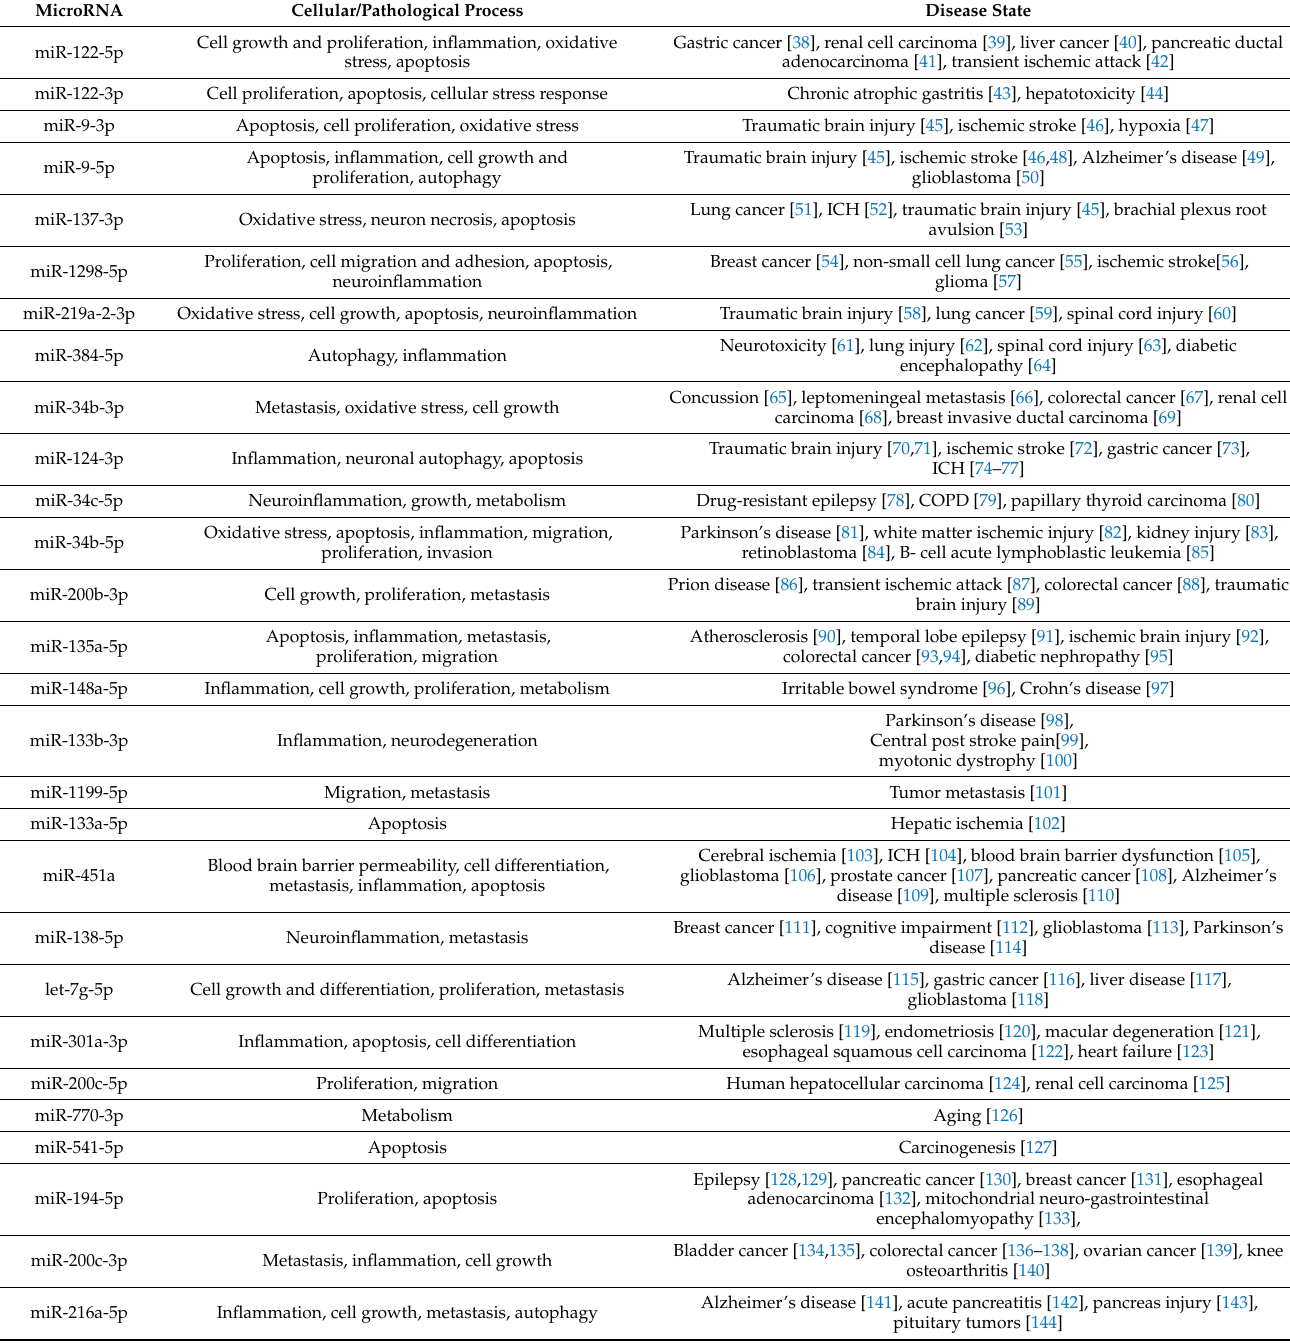
Table 2. Pathological processes and disease states associated with dysregulated miRNAs after